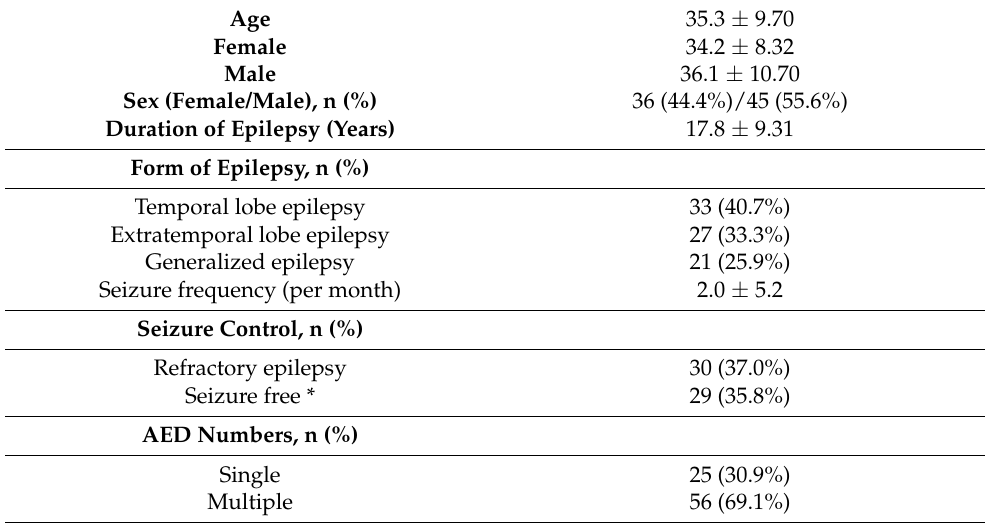
Table 1. Demographic and clinical characteristics of 81 patients with